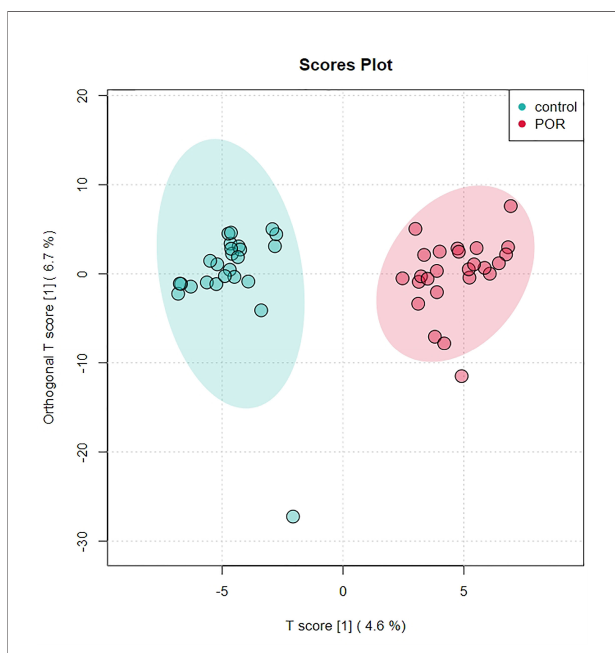
FIGURE 5 | Score plot analysis of OPLS-DA of group of POR and controls. Each point corresponds to a sample. Different groups are marked with different colors, and the region marked by ellipse is the 95% con fi dence region of sample